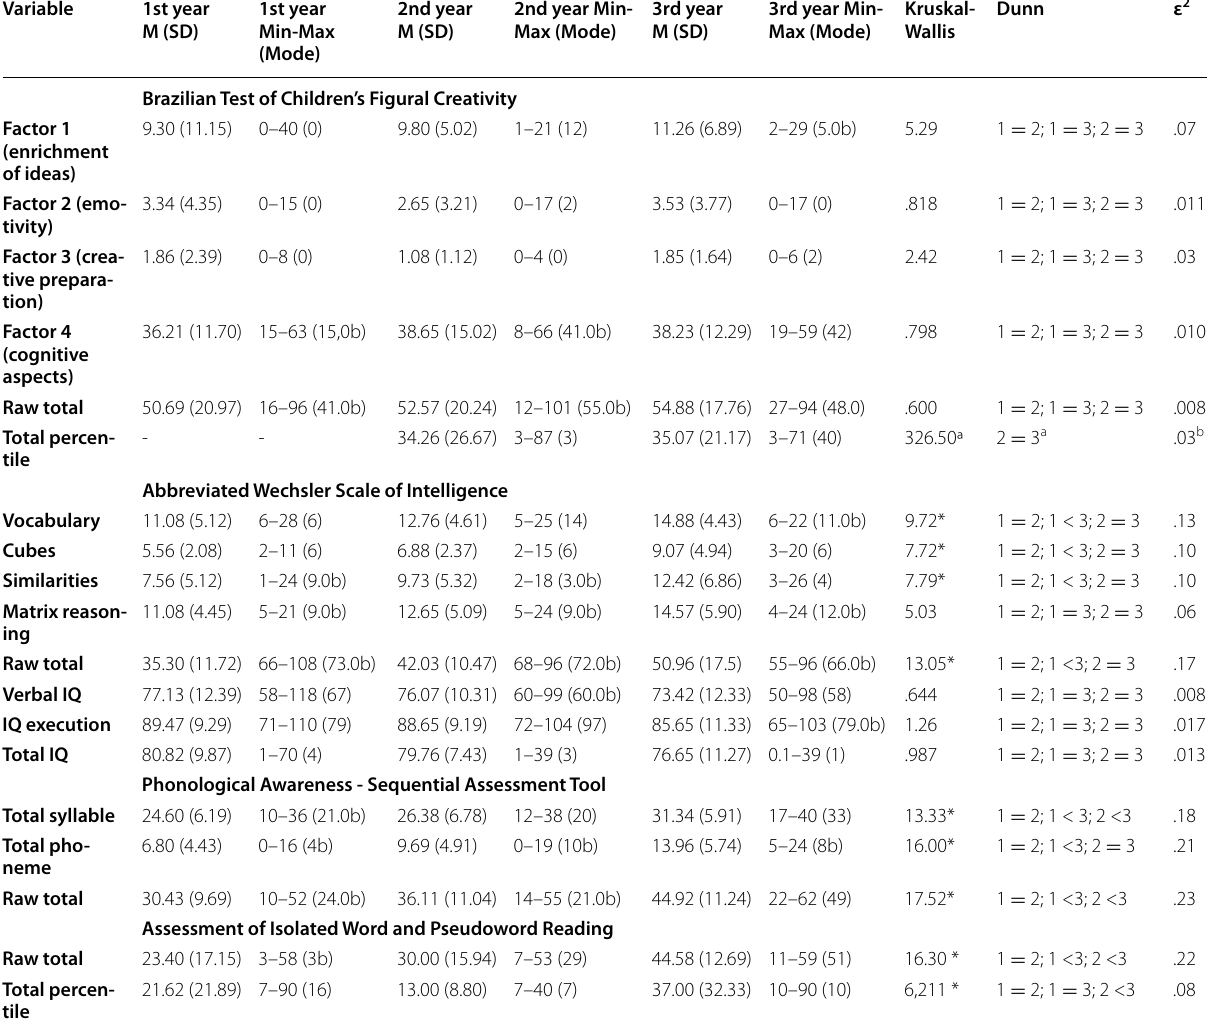
Table 1 Descriptive statistics and comparison between school years in administered